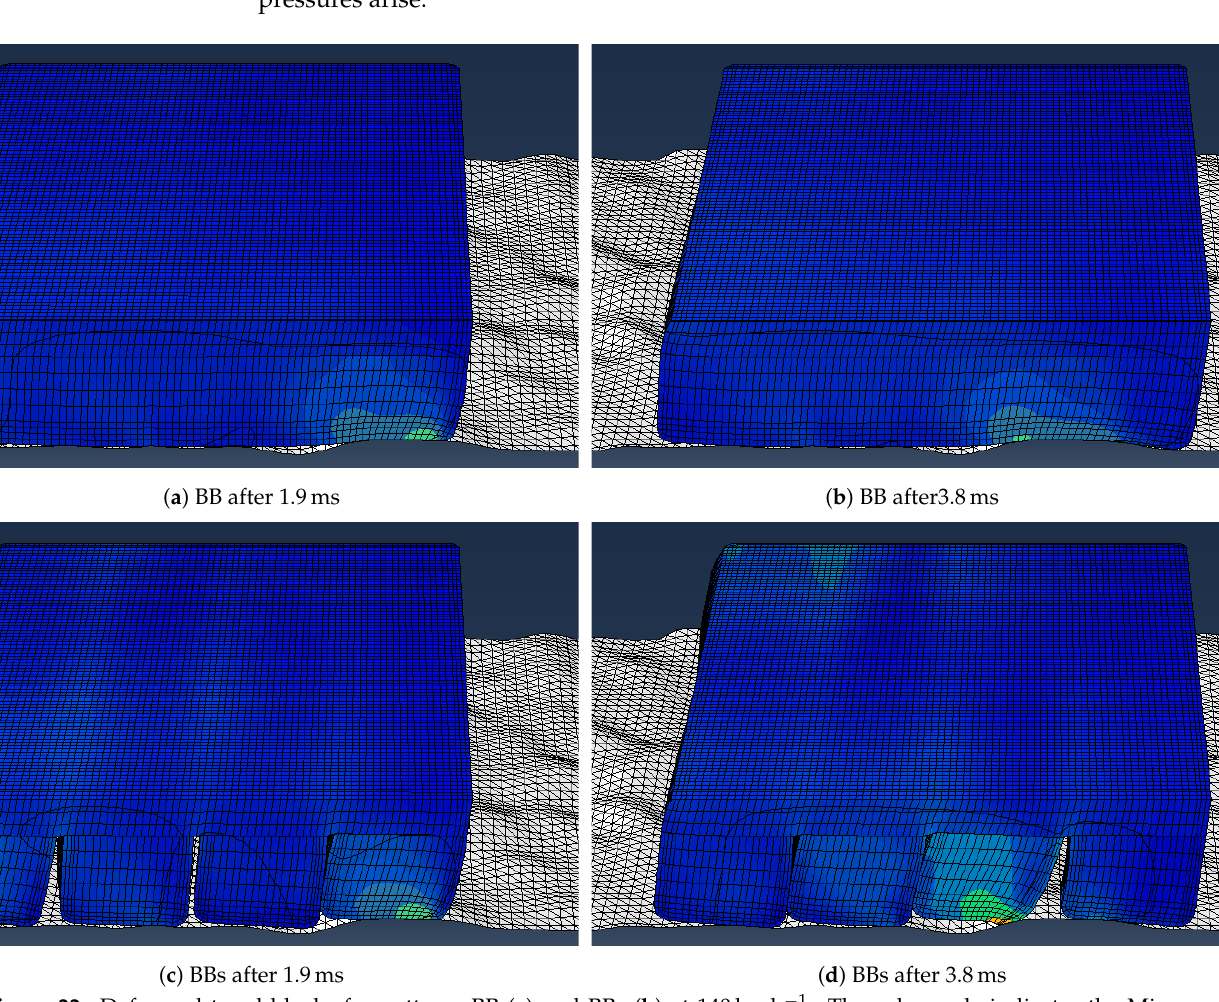
Figure 22. Deformed tread blocks for patterns BB ( a ) and BBs ( b ) at 140kmh − 1 . The color scale indicates the Mises equivalent stress and covers the same range of values for all